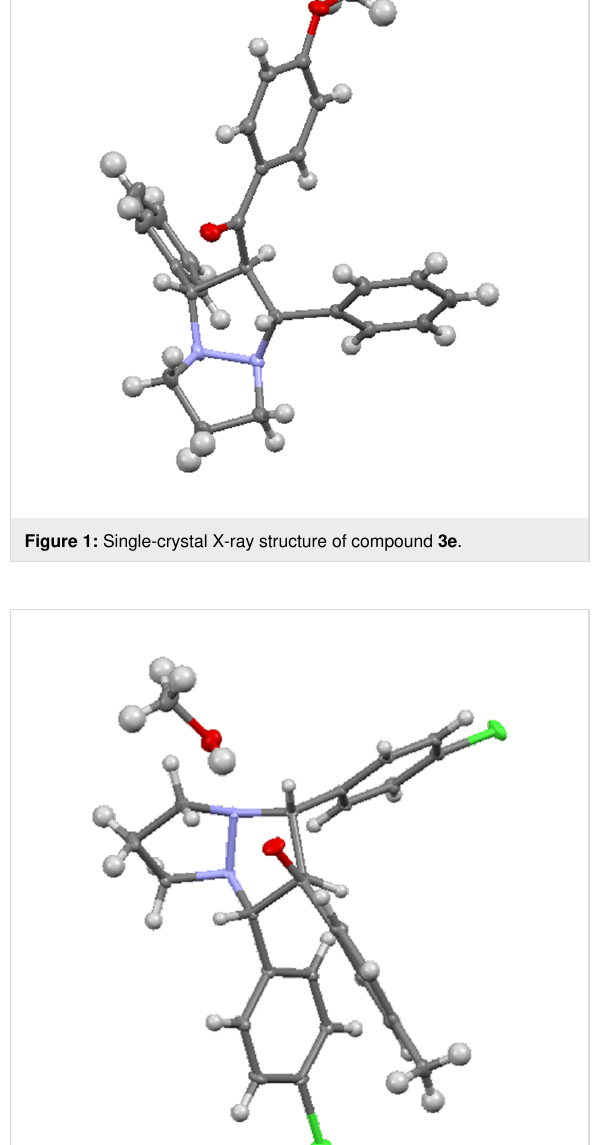
profound influence on the yields of a catalytic reaction (scan- dium triflate with a chiral ligand); when a phenyl or p -chloro/ methylphenyl-substituted diaziridine was employed, the cyclo- addition products were obtained in only 11–24% yields, and good yields were achieved mostly with diaziridines containing electron-donating substituents [30]. In our case the products were obtained in good yields in all cases except for compound 3k (12%), that was mainly due to difficulties in the